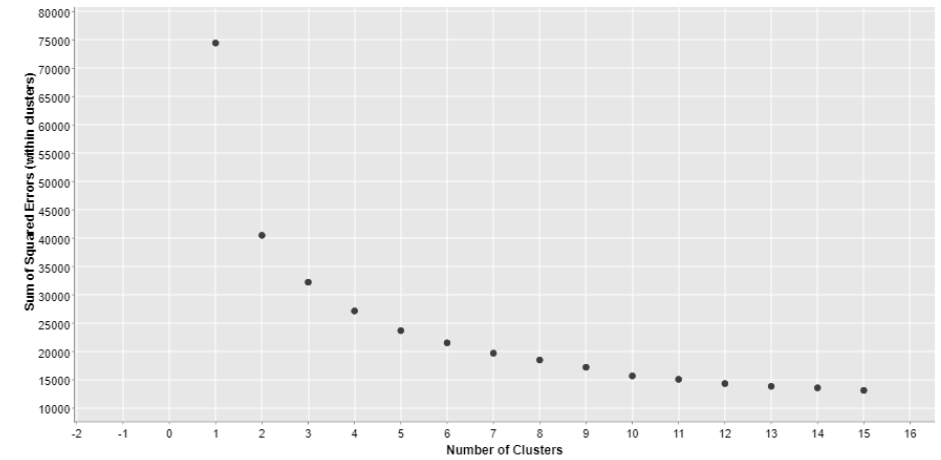
Figure 12. Elbow graph to decide the optimal number of clusters. Clustering was performed using the k-means algorithm. Variables used to define cus- tomer clusters were the fuzzy linguistic 2-tuple RFMScore per each product hierarchy. Fig- ure 13 shows the radar plot for each cluster.